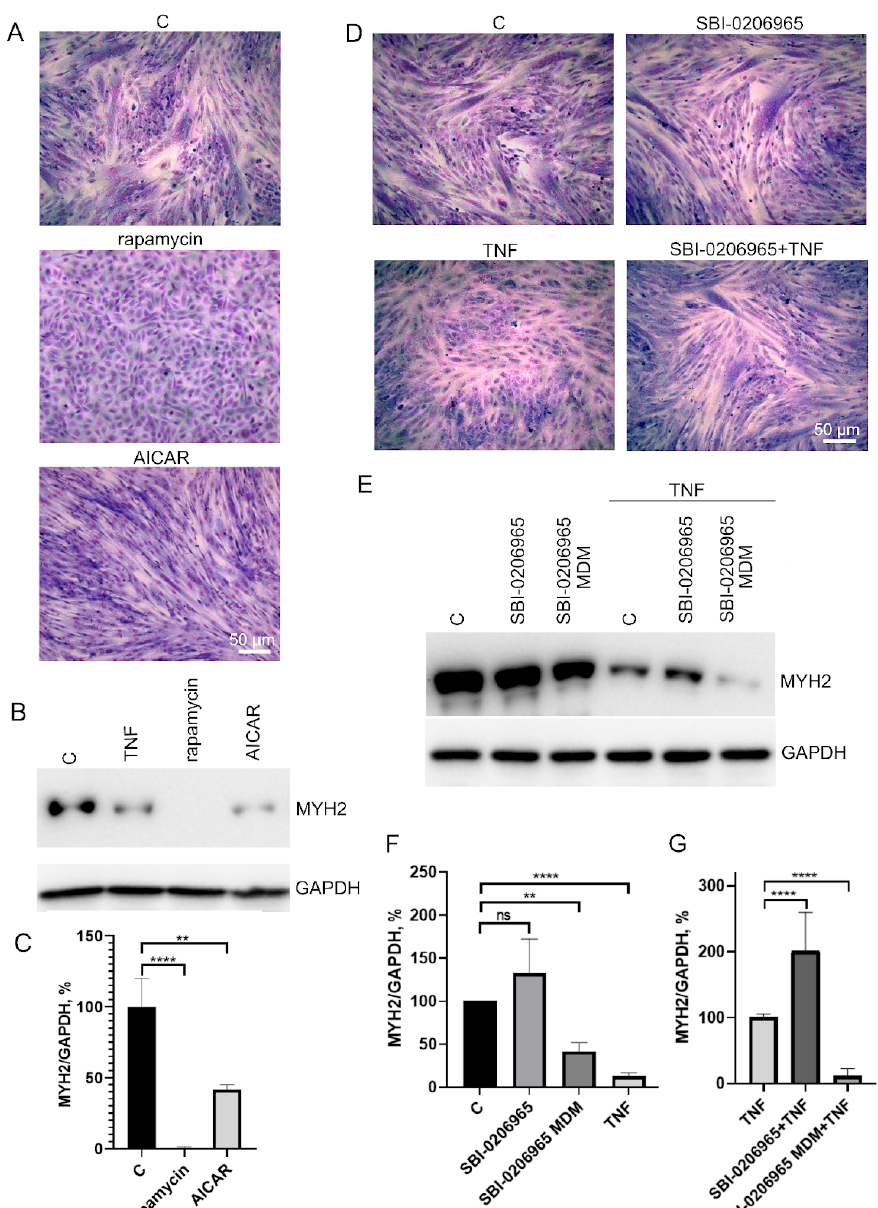
Figure 6. Effects of autophagy inducers (rapamycin and AICAR) and autophagy inhibitor SBI-0206965 on myoblast differentiation. Cells were treated with 50 ng/mL TNF 24 h before the induction of differentiation. Rapamycin (100 nM) and AICAR (0.5 μ M) were added 24 h before differentiation induction, SBI-0206965 (5 μ M) was added 30 min before TNF or to the differentiation medium (MDM) where indicated. Differentiation was analysed on day 3 after induction. ( A , D ) Formation of myotubes as revealed by May–Grunwald staining. Representative images, Scale bar: 50 μ m. ( B , C ) The effect of autophagy inducers on MYH2 expression. Representative Western blot ( B ) and the results of densitometric analysis ( C ). ( E – G ) The effect of the autophagy inhibitor on MYH2 expression in the control and TNF-treated myoblasts. SBI-0206965 was added either 30 min before TNF or in the differentiation medium (MDM). Representative Western blot ( E ) and the results of densitometric analysis of Western blots ( F , G ). All the data are presented as mean ± SD, **— p < 0.01, ****— p < 0.0001, n ≥ 3, ns: no significant difference. Data are presented as % relative to untreated control in ( C , F ) or as % relative to TNF in ( G